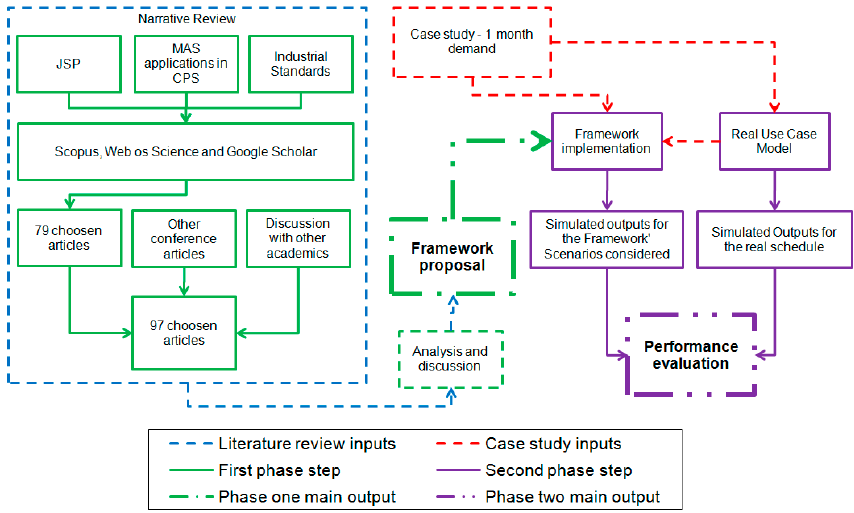
Figure 1. Research Procedure workflow.